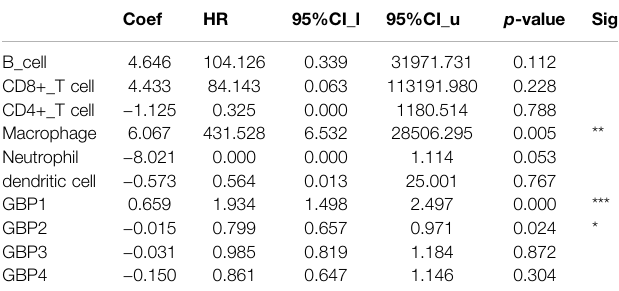
TABLE 3 | The cox proportional hazard model of GBP1/2/3/4 and six tumor- in fi ltrating immune cells in KIRC (TIMER). Coef HR